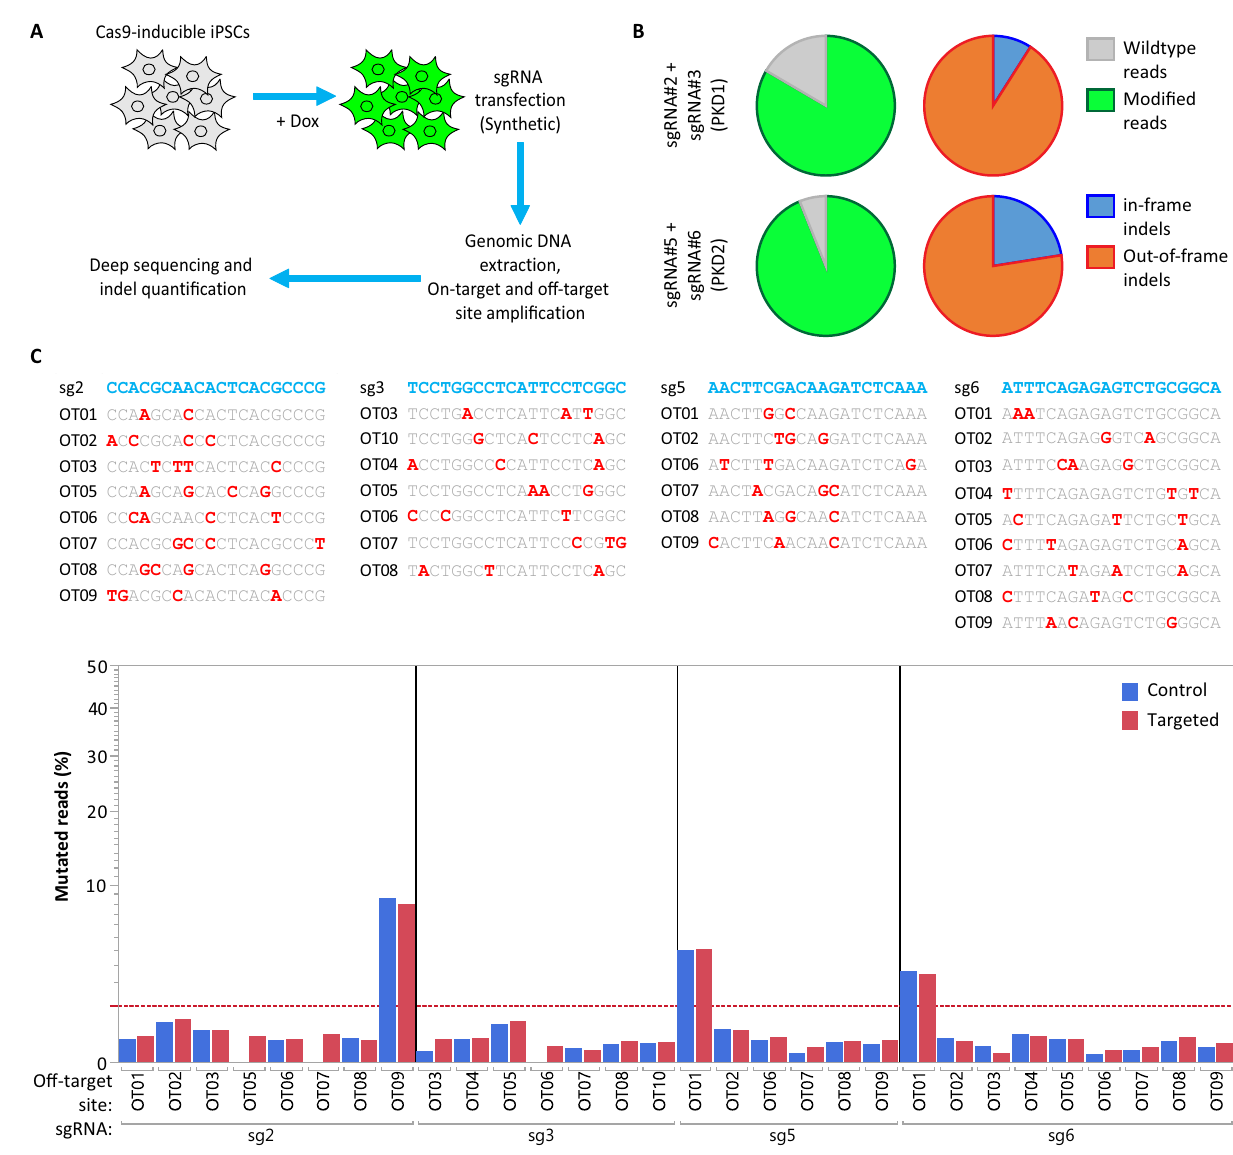
Figure 3. Paired-sgRNA strategy resulted in higher indel rate in hiPSCs. ( A ) Schematic outline of the experiment is shown. ( B ) The percentage of the modified reads for on-target loci were measured using deep targeted sequencing. ( C ) No Cas9 off-target activity was detected at the selected off-target sites. Samples were analyzed using deep targeted